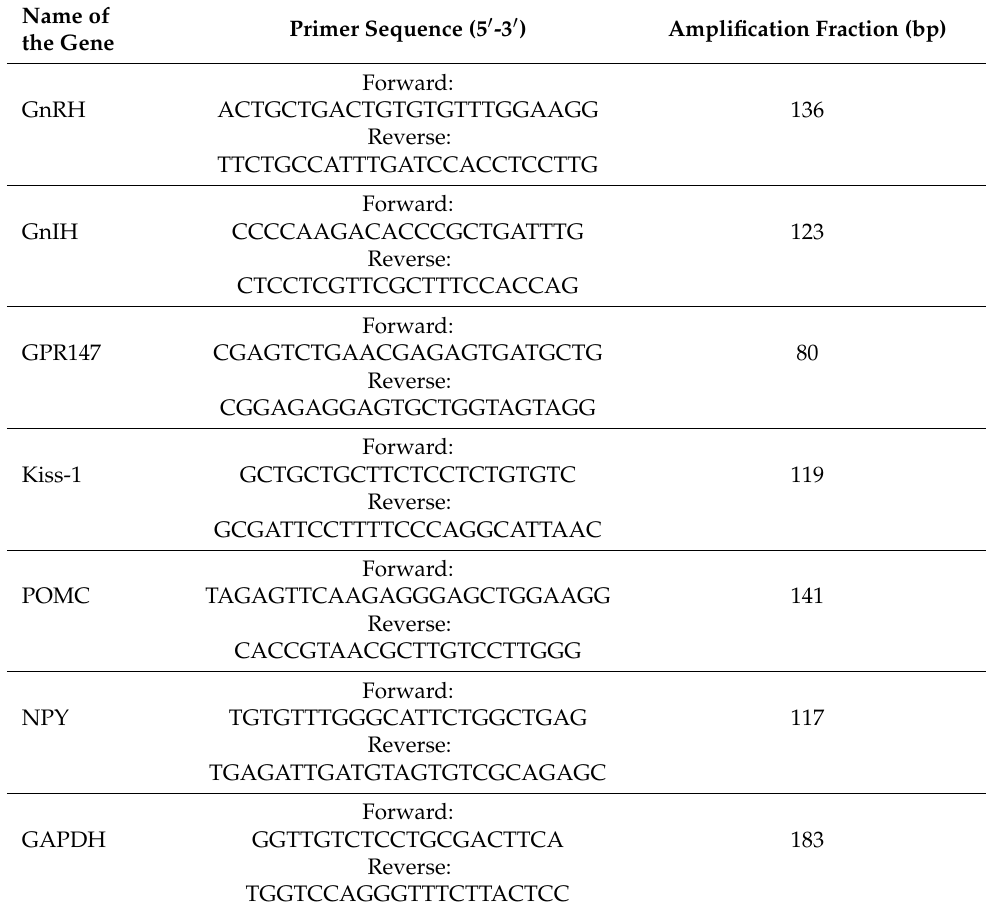
Table 1. Primers’